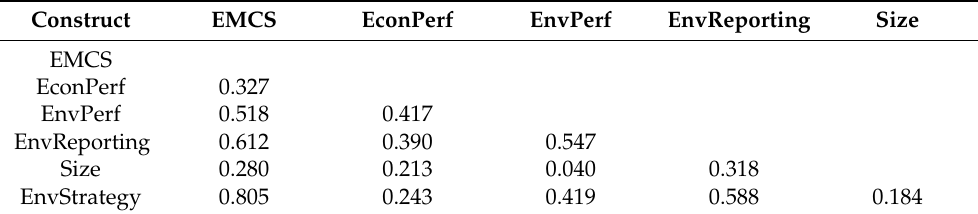
Table 4. Discriminant validity (Heterotrait-monotrait Ratio,